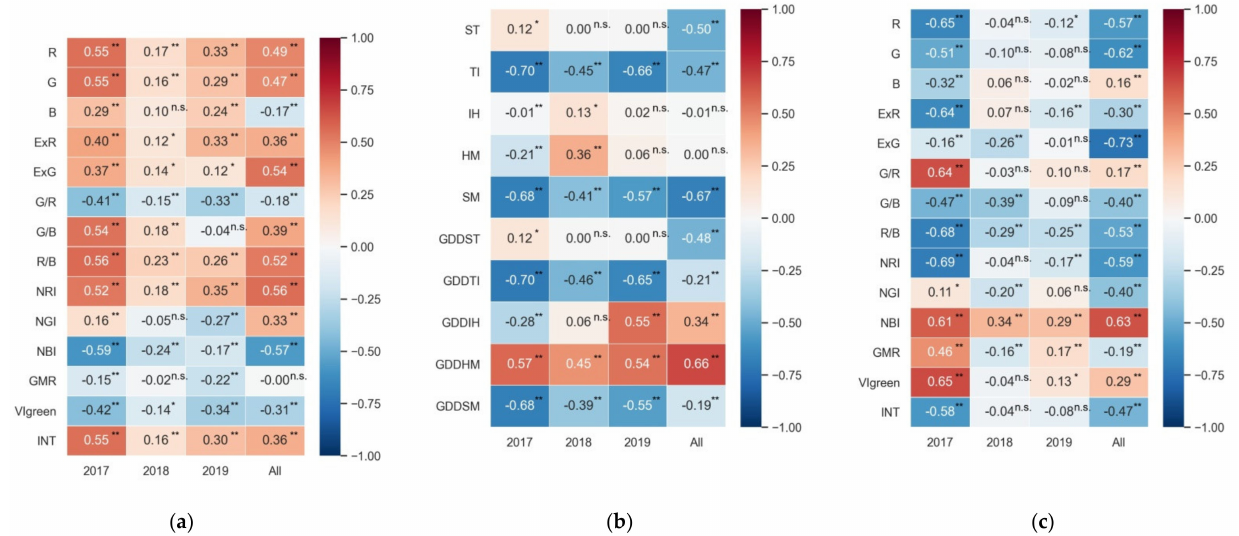
Figure 4. Pearson correlation coefficients between ( a ) VIs and yield, ( b ) phenology and yield, and ( c ) VIs and GDL for all cultivars across the years. The numbers in panels ( a – c ) represent the Pearson correlation coefficients. Note: * F-test statistical significance at the 0.05 probability level. ** F-test statistical significance at the 0.01 probability level. n.s. refers to no statistical significance.